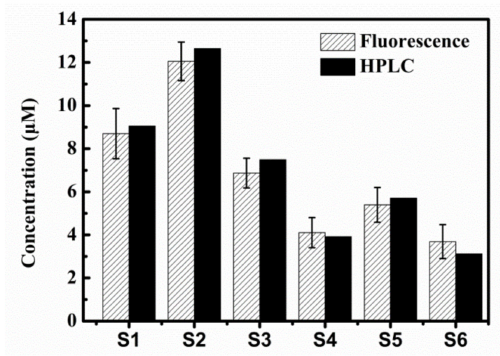
Figure 4. Content of ca ff eine in six samples was determined by HPLC (black) or by fluorescence spectroscopy